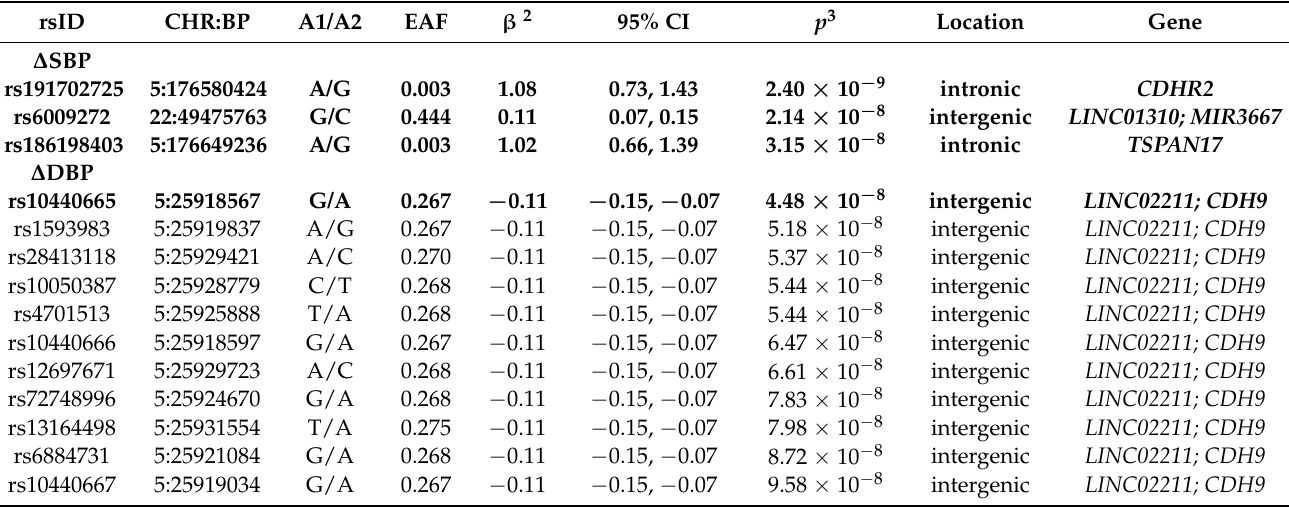
Table 3. Top variants associated with blood pressure response to chlorthalidone use over six months ( p < 1.00 × 10 − 7 ) 1 .